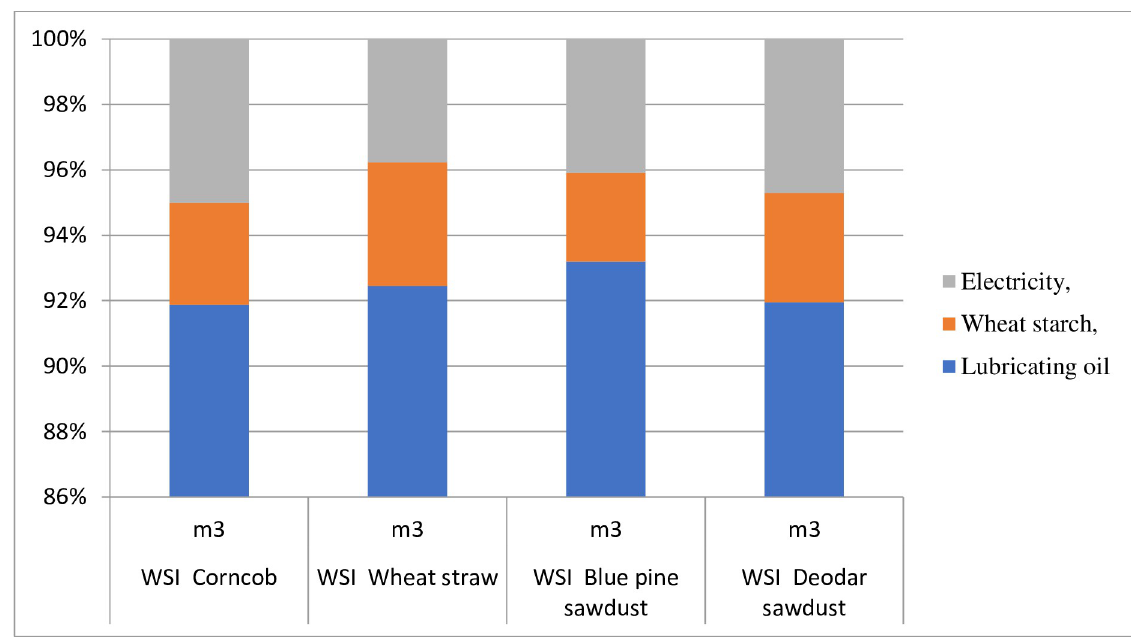
Fig 7. Water footprints of biomass pellets from various agroforest species residues.